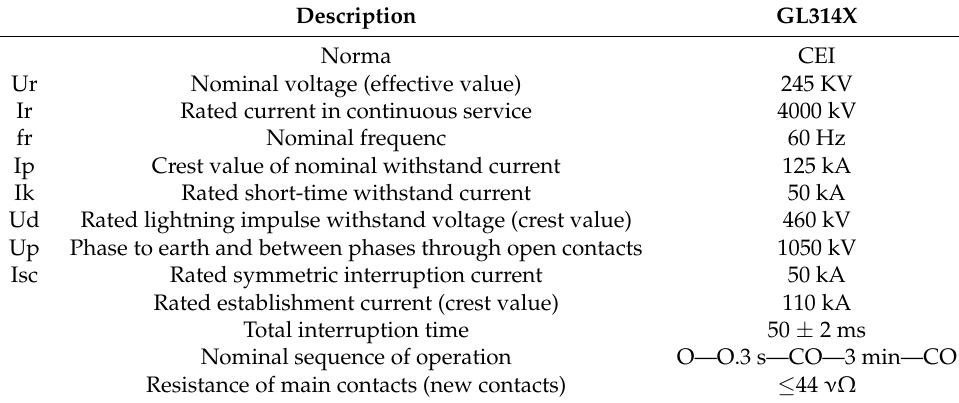
Figure 14. Bank of capacitors connected to the HVCB GL 314X. Table 2. HVCB GL 314X